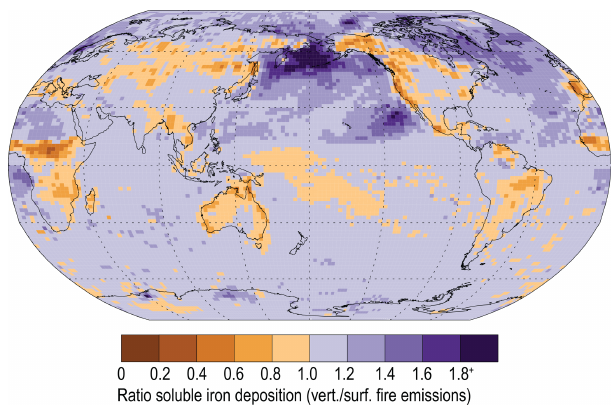
Figure 13. The ratio of soluble iron deposition from fires when emissions are emitted with a vertical distribution to fires when emis- sions are only at the surface (i.e. vertical / surface). Single year (2007) comparison only.